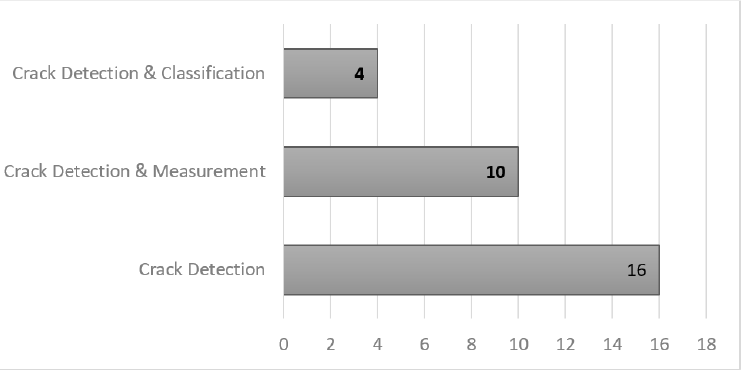
Figure 7. Functionality based Analysis of Crack Detection Methods.